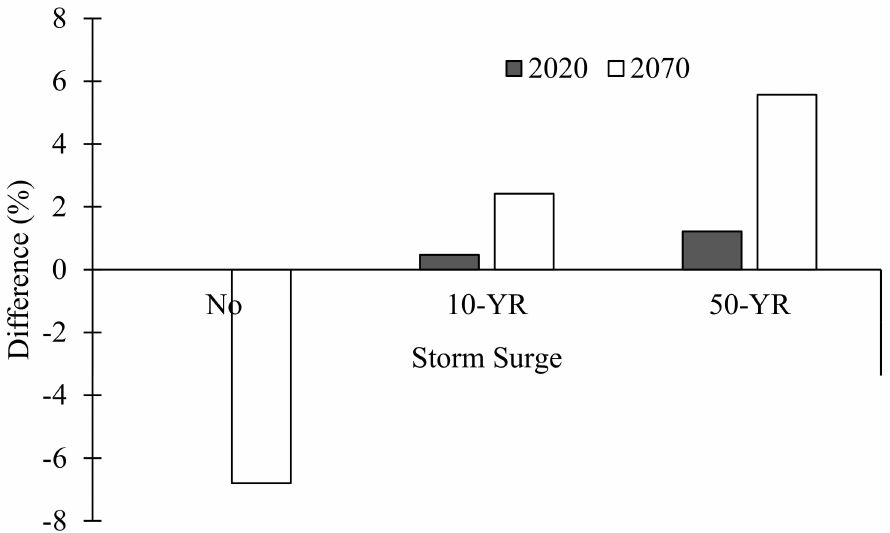
Figure 10. Comparison between flood area estimates from the bathtub method and the coupled flood model under the 10-year and 50-year storm surge events in 2020 and 2070 (no